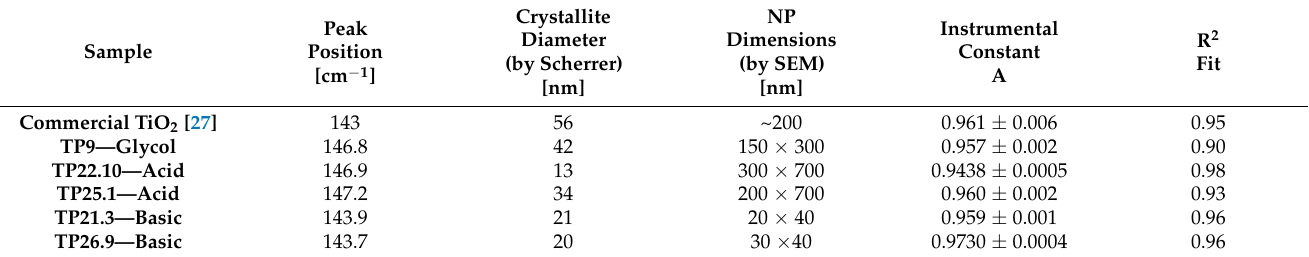
Table 4. Parameters of tested materials: position of the E g(1) peak, crystallite diameter estimated from XRD data, NP dimensions estimated from SEM images, values of A constant and R 2 of the fitting.